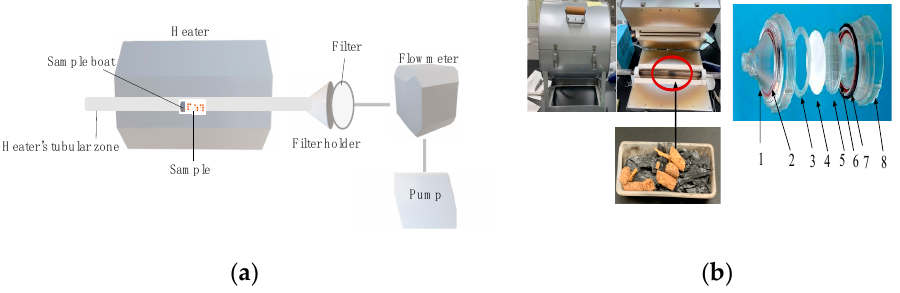
Figure 1. Laboratory sampling system. ( a ) Schematic diagram; ( b ) picture of the NILU filter holder system. See supplementary material for nomenclature (1–8).